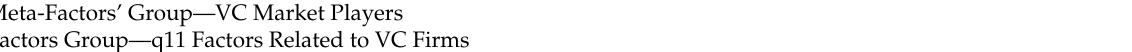
Table 20. Subfactors with substantial impact on the VC market listed in the order of importance. Meta-Factors’ Group—VC Market